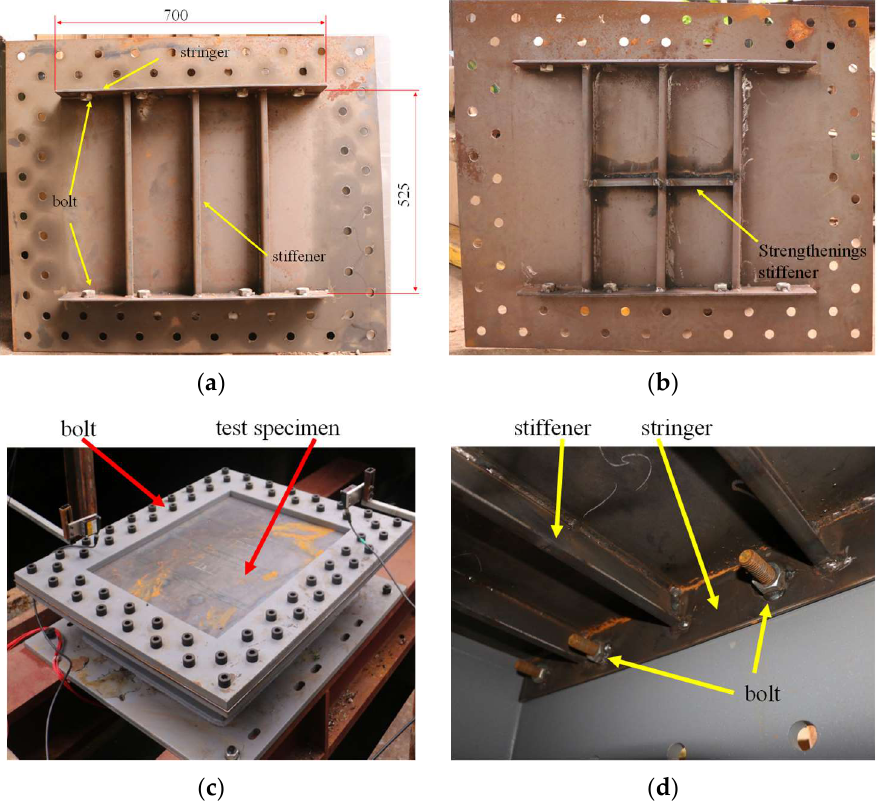
Figure 4. Photographs of the specimens: ( a ) conventional stiffened plate (unit: mm); ( b ) strengthened stiffened plate; ( c ) bolt arrangement; ( d ) stringer and the bolt on the backside.